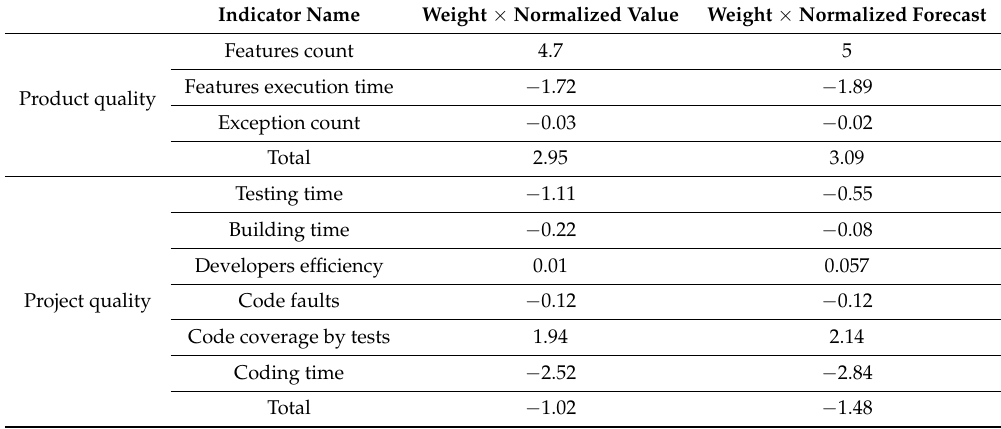
Table 4. Quality models